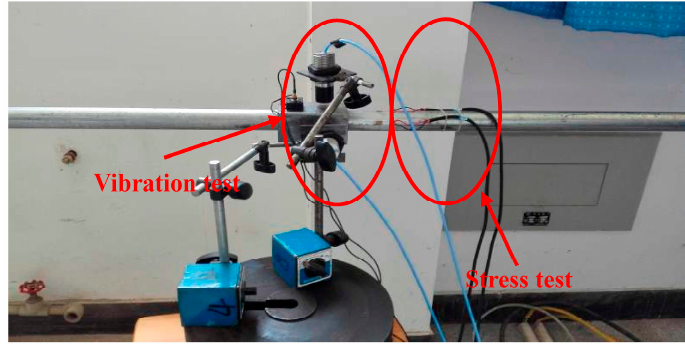
Figure 9. Physical map of pipe vibration test device and stress test device in straight pipe section.